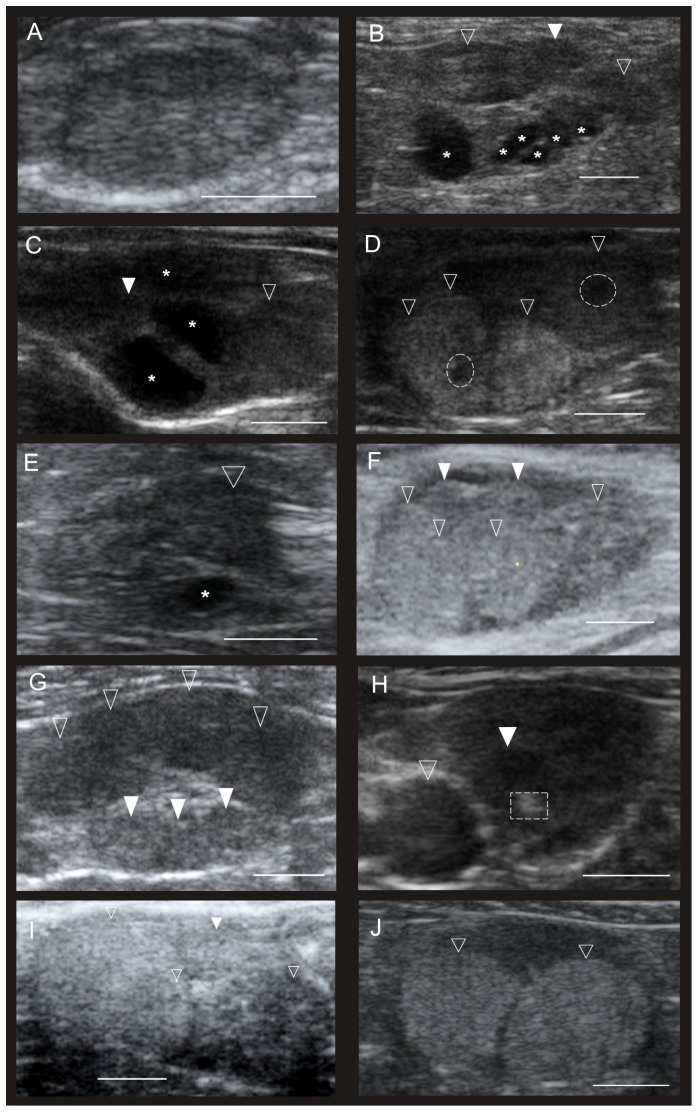
Ultrasonographical images of lynx ovaries during different reproductive stages.The ultrasound images (in b-mode) of lynx ovaries demonstrate different stages of ovarian activity. The white scale-bar indicates 1 cm. Asterisk indicates follicles, empty arrows show new CLs; full arrows show old corpora lutea (CLs) from previous years cycles. A: Juvenile lynx before puberty. Only the ovarian cortex is visible, no follicular or luteal structures; B: Pro-estrus in an adult lynx, small and medium sized, immature follicles appear next to CLs from previous years' cycles. C: Estrus in an adult lynx. Large, mature follicles and smaller immature follicles and an old CL from last year's cycle are visible; D: Met-estrus in adult lynx after recent ovulation. One old CL is visible. Two freshly ovulated, plicated follicles whose walls have begun to luteinize and formatting a new CL, centre parts are not yet fully closed (interrupted circles); E: second follicular wave, observed in only one animal during May, about 65 days after first estrus. Only one medium sized follicle visible; F: Pseudo-pregnancy in lynx. CLs without mating, no pregnancy, 1 month after spontaneous ovulation; G: Prolonged di-estrus during winter. Physiologically persisting CLs are hypo-echoic and still quite large; H: Corpus albicans. Old CL (interrupted rectangular) undergoes structural regression. CLs' tissue becomes denser and hyper echoic in ultrasound; I: Pregnancy at day 31 post copulation, CL appear hyper echoic; J: CL during lactation in lynx. Large, hyper echoic CL's.